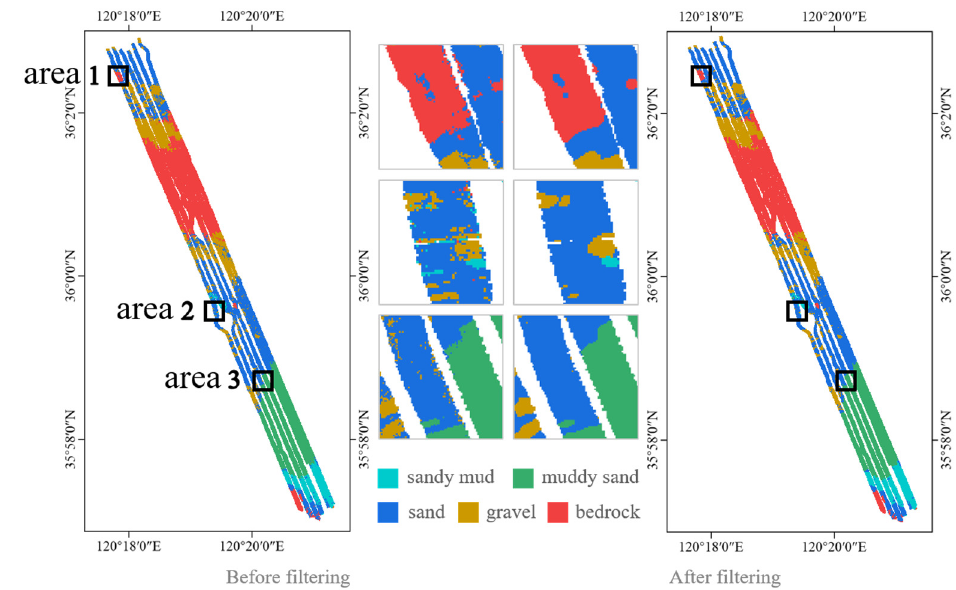
Figure 10. Sediment maps and details before and after